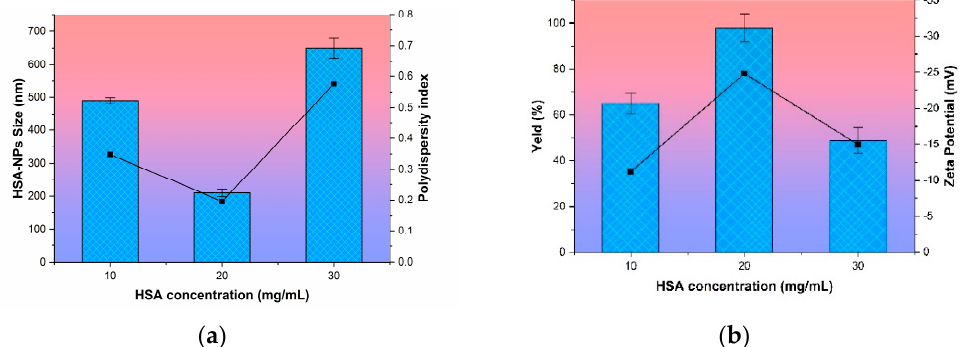
Figure 1. Effect of the concentration of human serum albumin on ( a ) nanoparticle size and polydispersity index of human serum albumin nanoparticles (HSA-NPs) and ( b ) the zeta potential and yield of HSA-NPs. Size and yield are represented as columns, and polydispersity index and zeta potential are represented as lines.